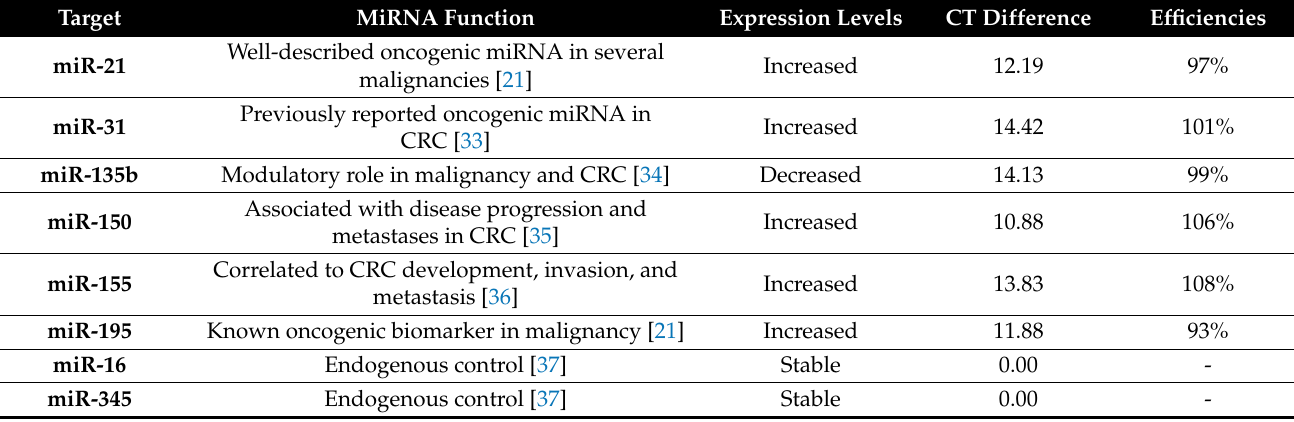
Table 2. Brief descriptions of the relevance of the 6 target miRNA and 2 endogenous controls in the setting of colorectal and other